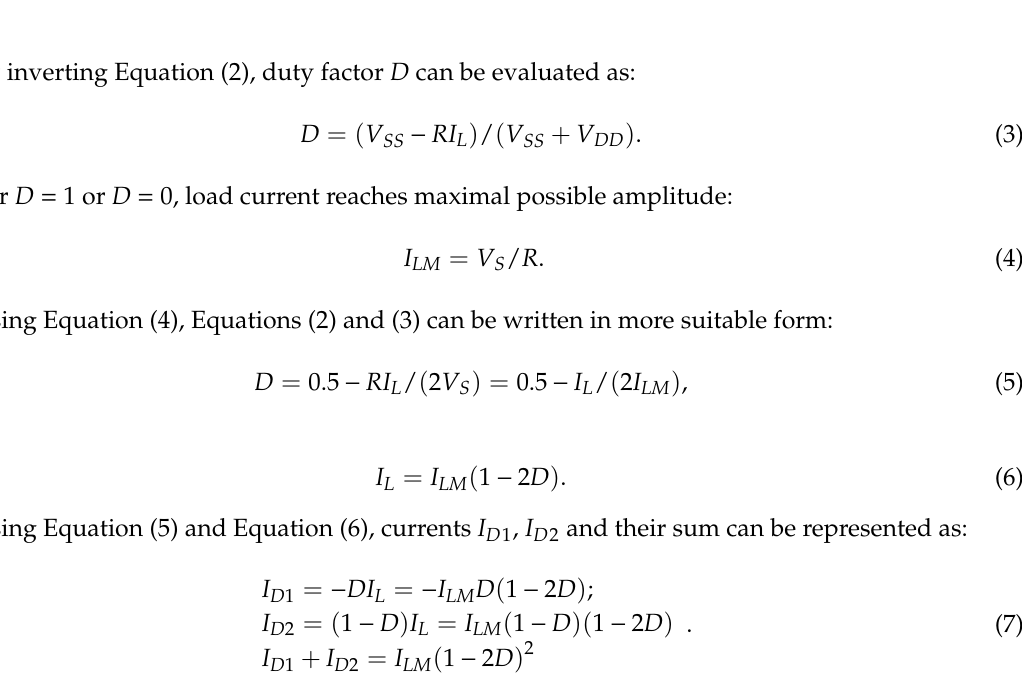
Figure 1. Basic configuration of class-D half-bridge (HB) amplifier without control circuitry. Amplifier